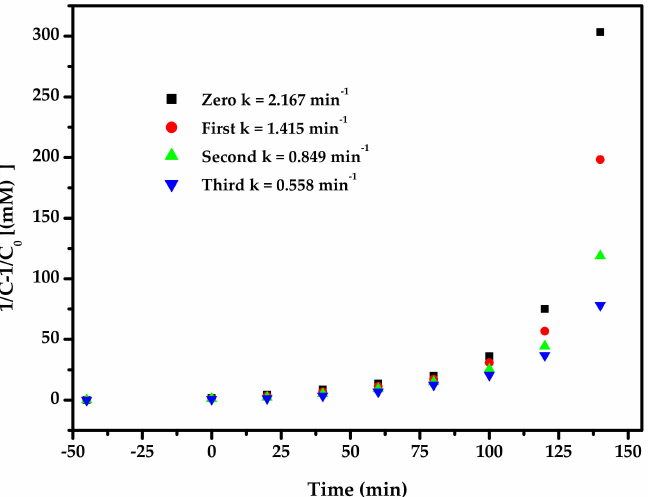
Figure 17. Achieved second-order dynamic curves for the PD of DO with Bi 2 SmSbO 7 /ZnBiYO 4 heterojunction as the photocatalyst under VLI for three cycle degradation